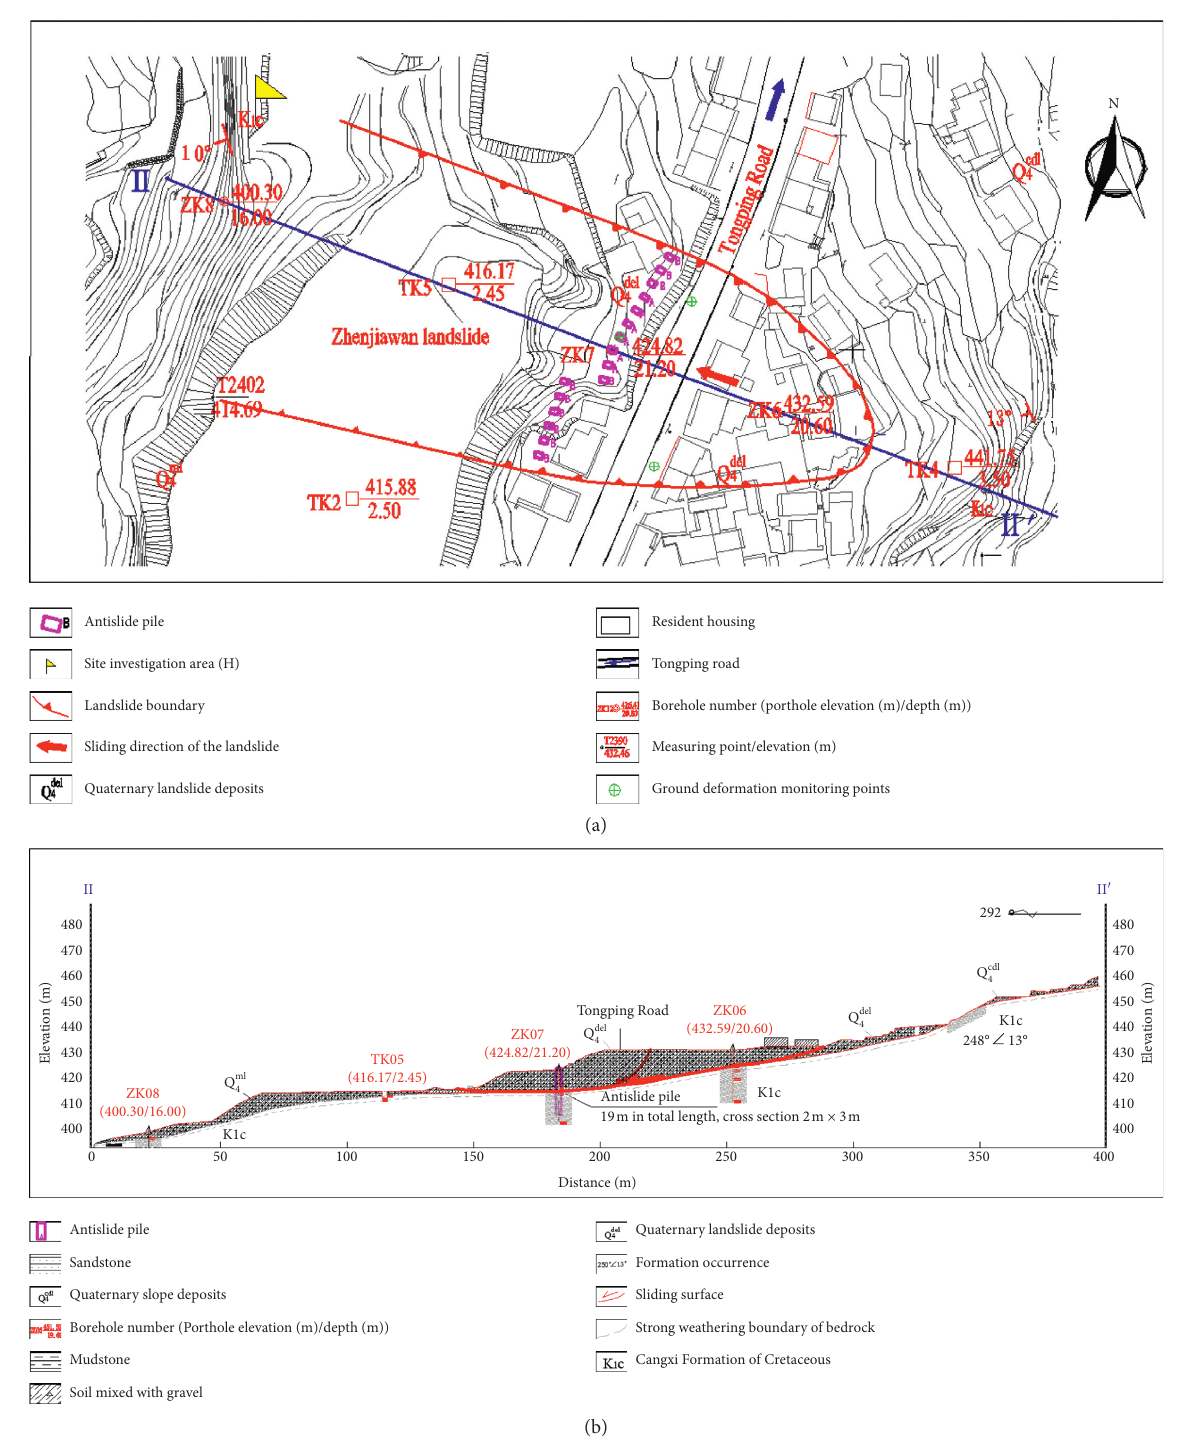
Figure 4: Engineering geology conditions of Zhangjiawan landslide. (a) Geological map of the Zhangjiawan landslide. (b) Cross-section from II to II ′ of the Zhangjiawan